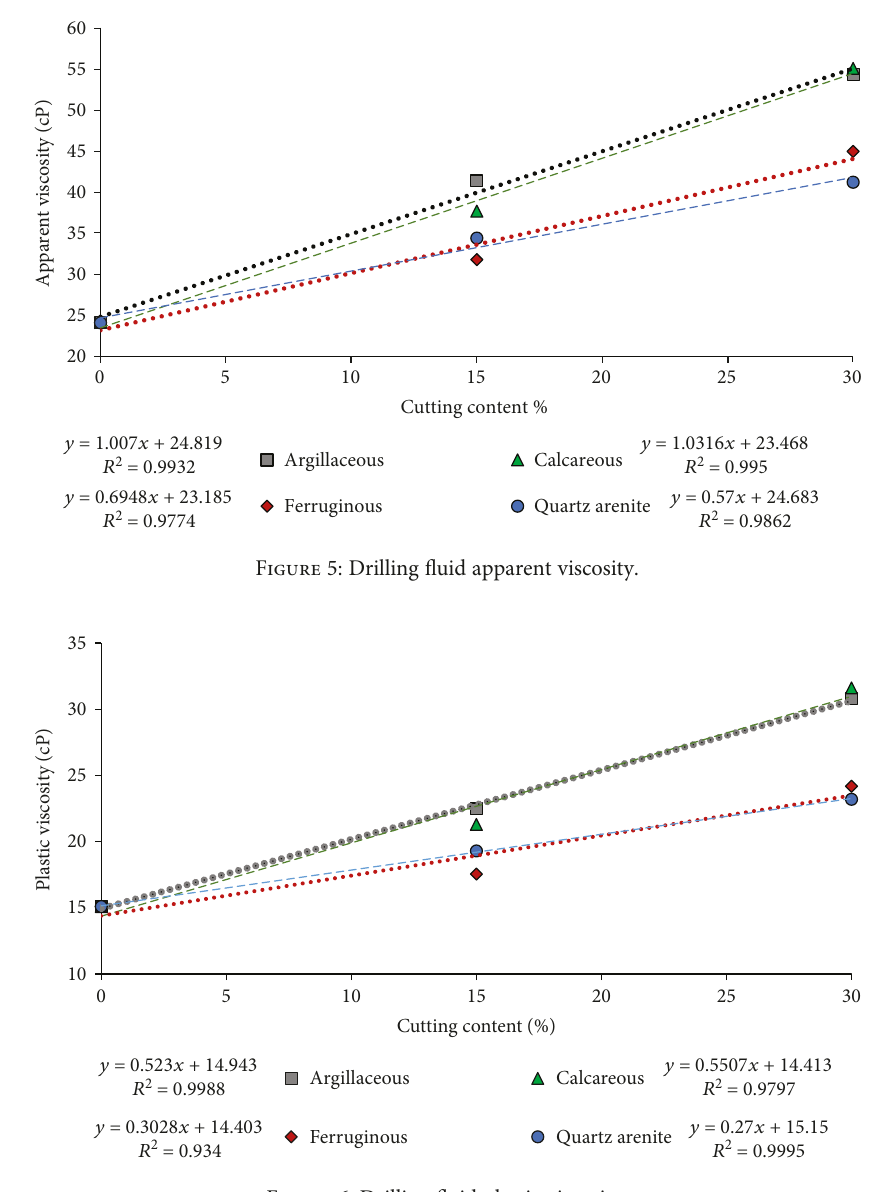
Figure 6: Drilling fl uid plastic